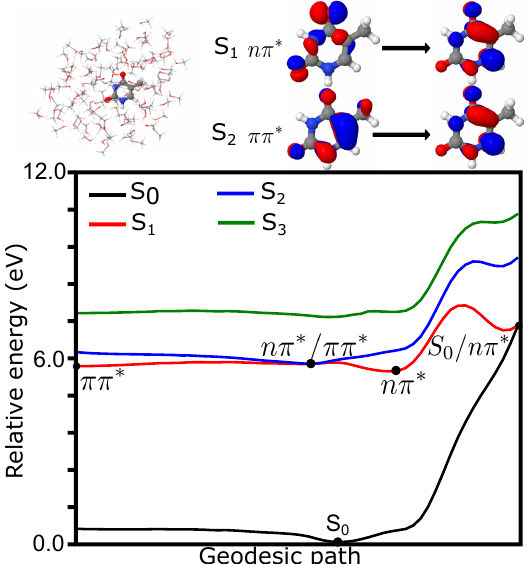
Figure 3. Photochemistry of thymine in methanol. ( top , left ) Schematic structure of thymine and methanol QM/MM model. ( top , right ) Main character of the transitions representing the first and second singlet excited states. ( bottom ) Geodesic path connecting the conical intersections between S 0 / n π ∗ , S 0 / ππ ∗ and n π ∗ / ππ ∗ as well as S 0 and n π ∗ minima. Energies (in eV) have been computed at the TDA-TDBH&HLYP/6-31G* level.